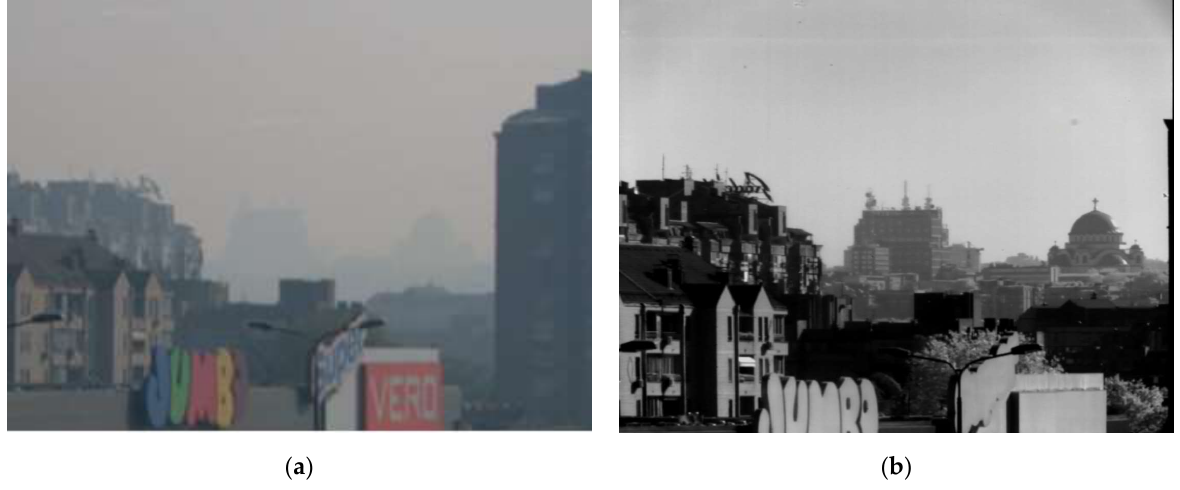
Figure 2. Image of a building at a distance of 4.3 km: ( a ) VIS, ( b ) SWIR.